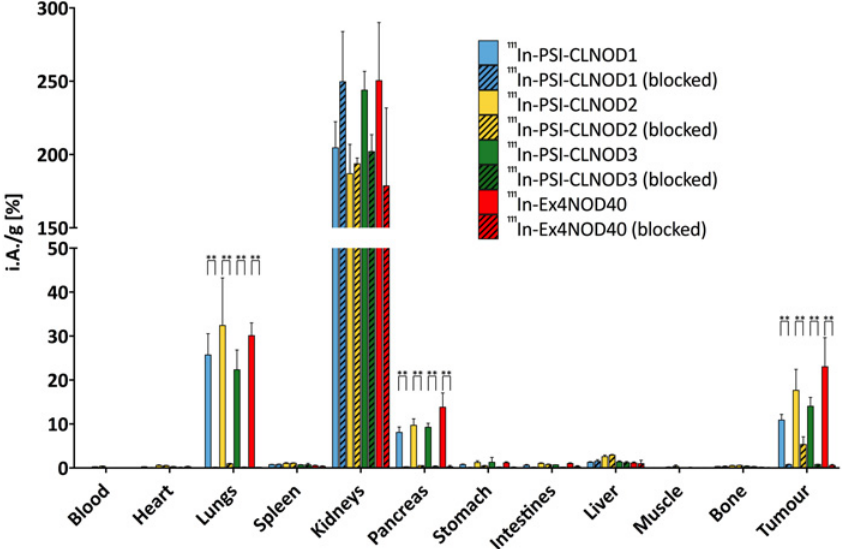
Fig 9. Biodistribution of 111 In-labeled peptides in CD1 nu/nu mice with CHL-GLP1R positive tumour- xenografts. Values are mean percentages injected dose per gram tissue ( n = 4. Error bars SD). Blocking was performed by pre-injection of 100 μ g excess of unmodified exendin-4. Mice were sacrificed 4 h after injection. The significance was tested by a two-was ANOVA test corrected for multiple comparisons